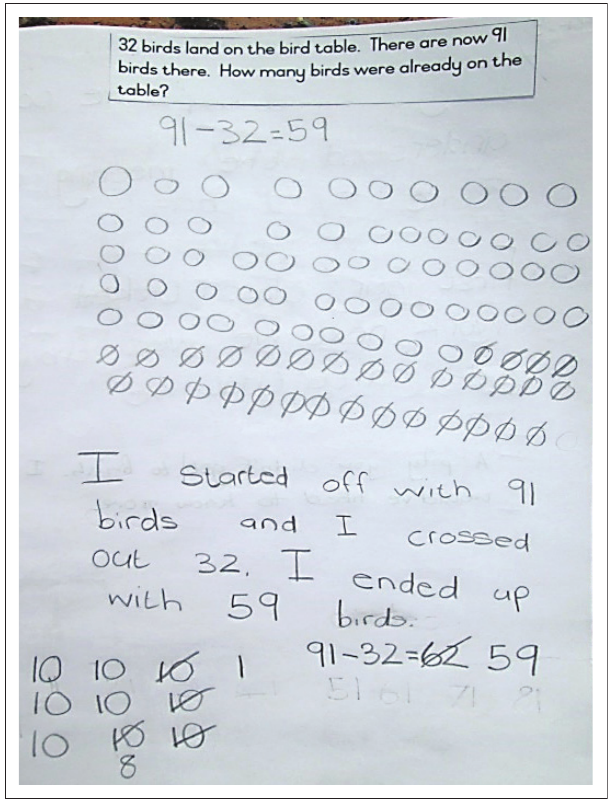
FIGURE 11: Gemma (Intervention-Problem 1).